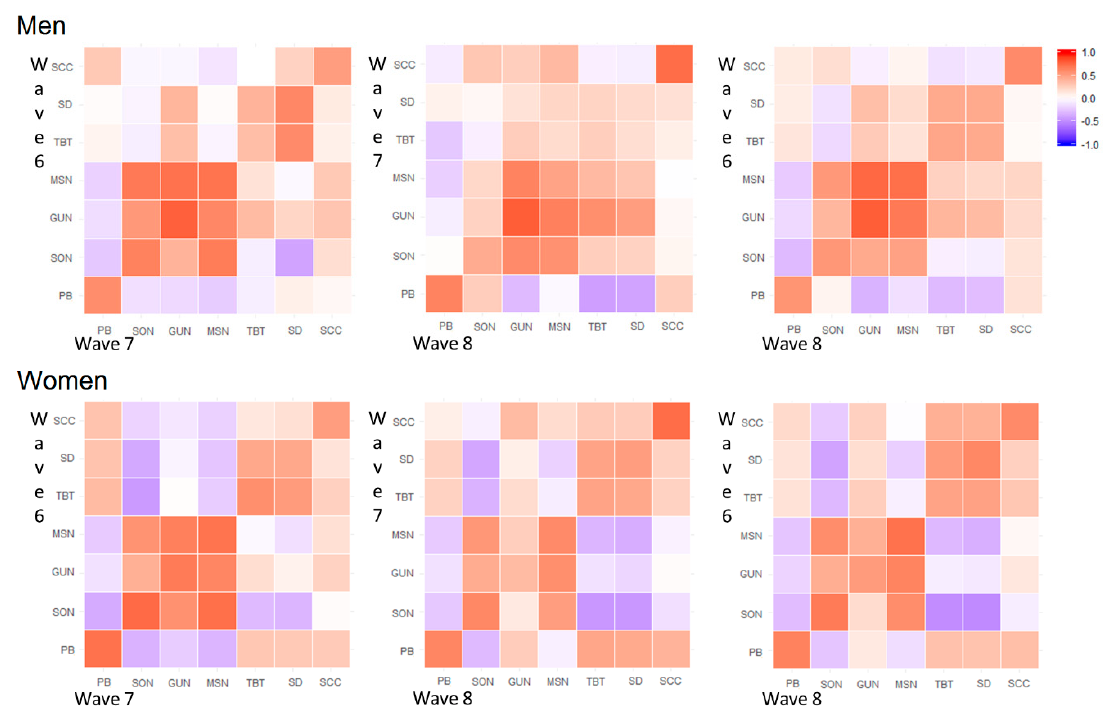
Figure 3. Heat maps of Pearson correlation coefficients of sleeping features, child sleep quality scores, and relationship satisfaction scores for di ff erent time points during free days. Note: SCC: Child sleeping quality score, PB: Partner relationship score, SD: Sleep duration, TBT: Time spent in bed, MSN: Middle sleep, GUN: Time getting out of bed, SON: Sleep